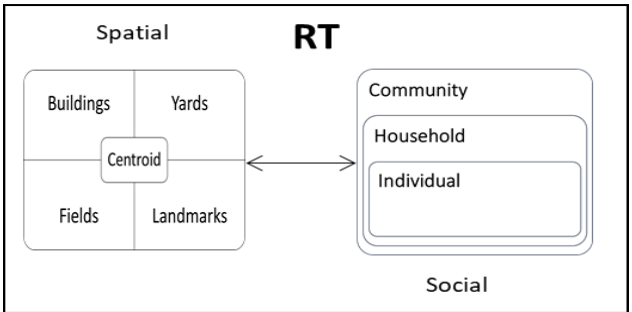
Fig. 10. The relationship between spatial and social components of an RT RT is a polygon in shape; therefore, a centroid